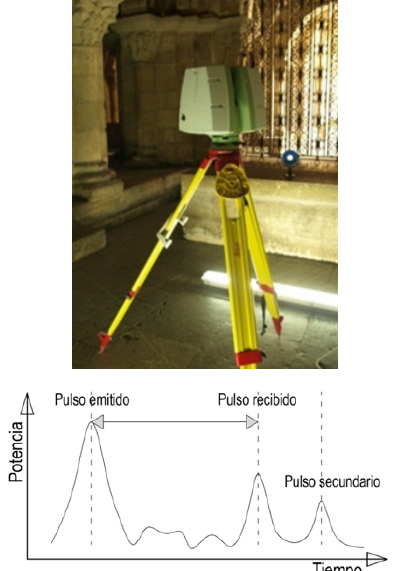
Figure 3. Pulse round-trip timing as ranging principle in TOF